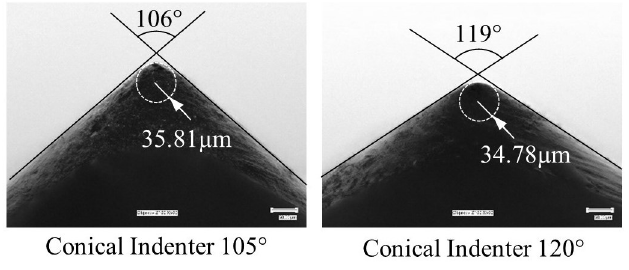
Figure 9. Microscope images of diamond indenters with cone angle and